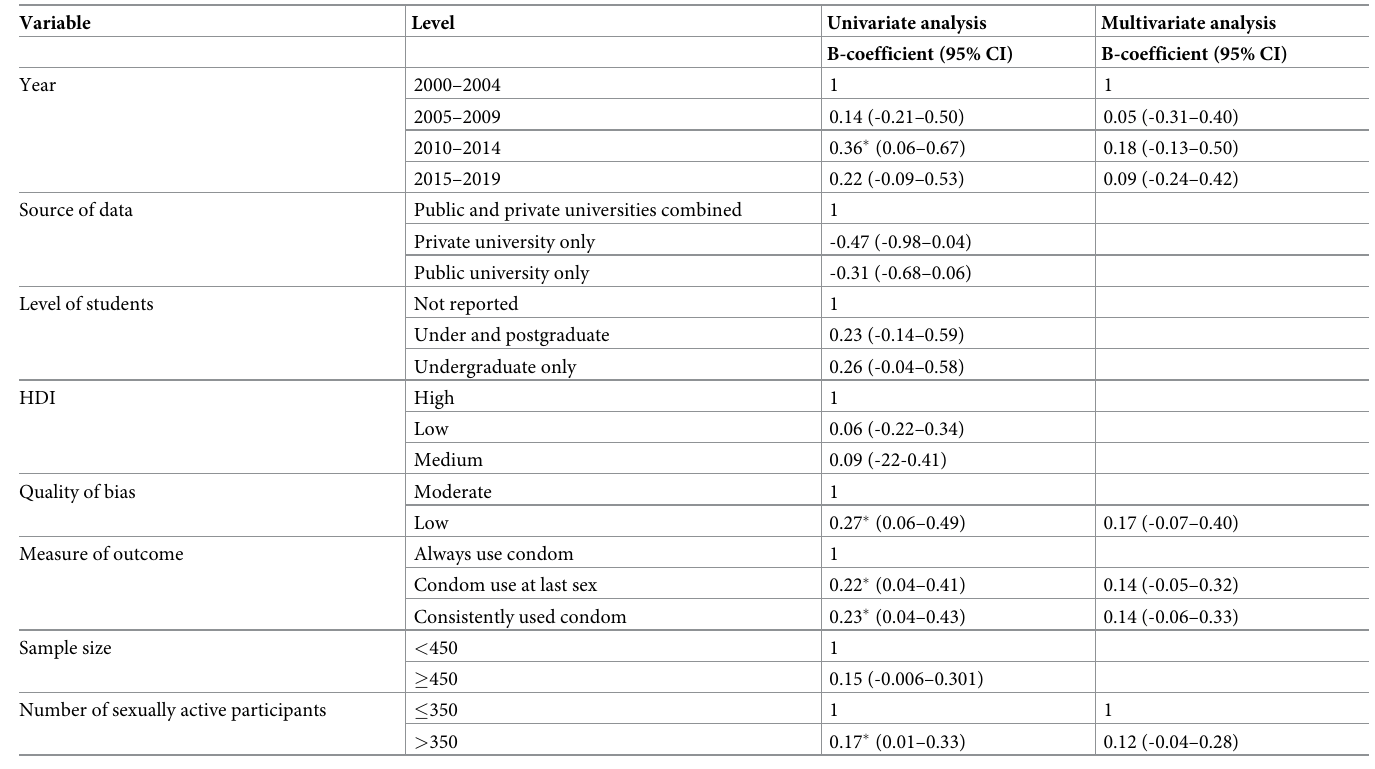
Table 3. Univariate and multivariate meta-regression